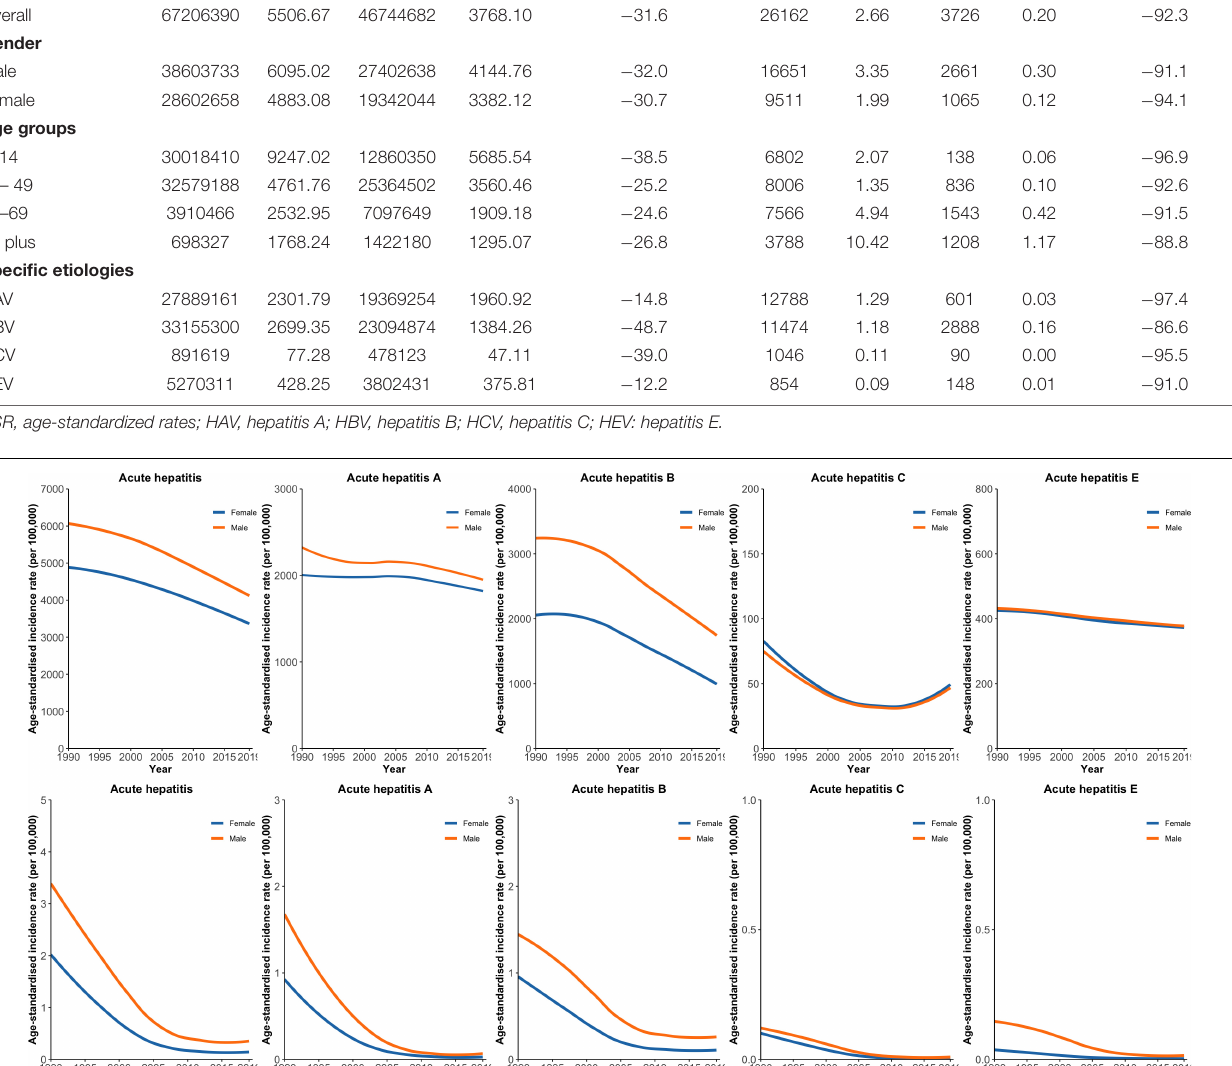
contributor to the global elimination of hepatitis B by 2030